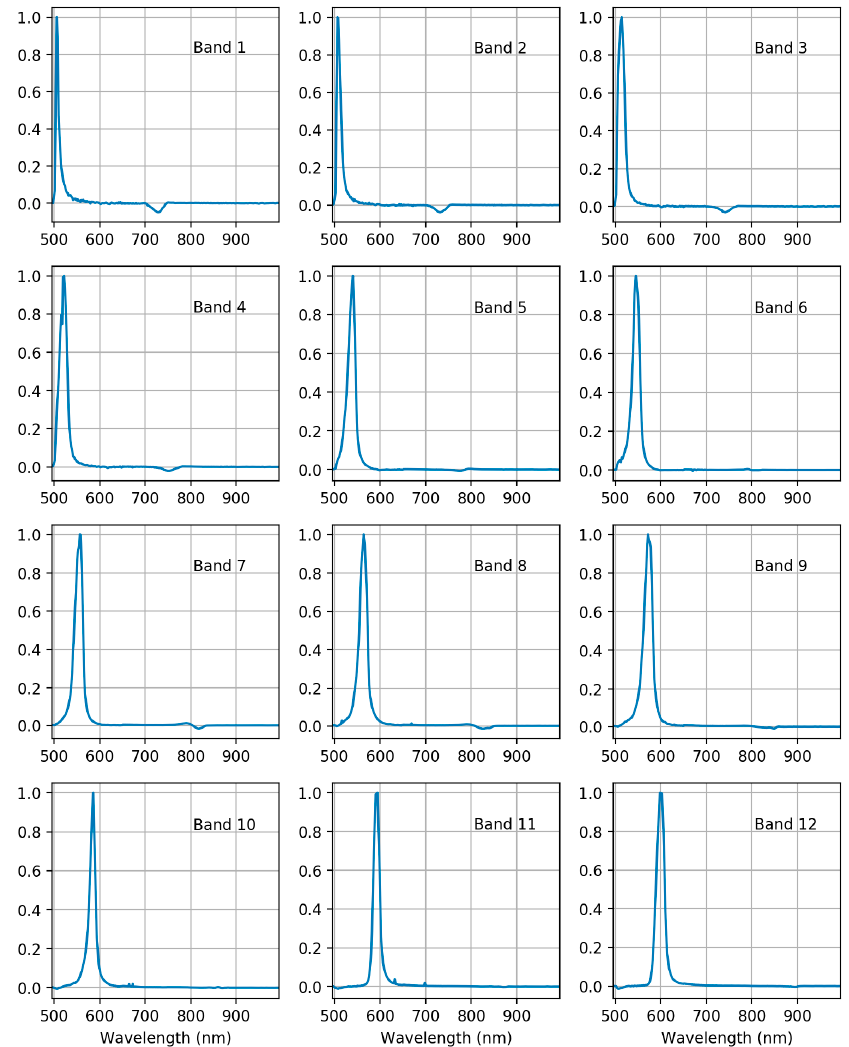
Figure A1. FPI spectral response curves for bands 1–12. Curves are scaled so that the maximum value is 1.